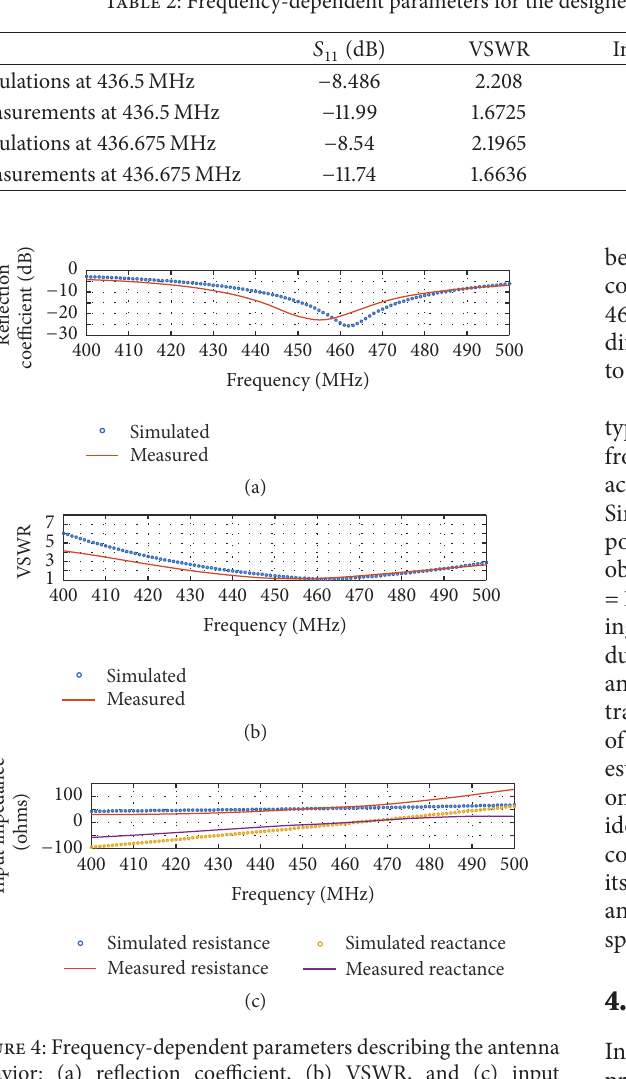
Table 2: Frequency-dependent parameters for the designed Koch antenna at 436.5 MHz and 436.675 MHz.